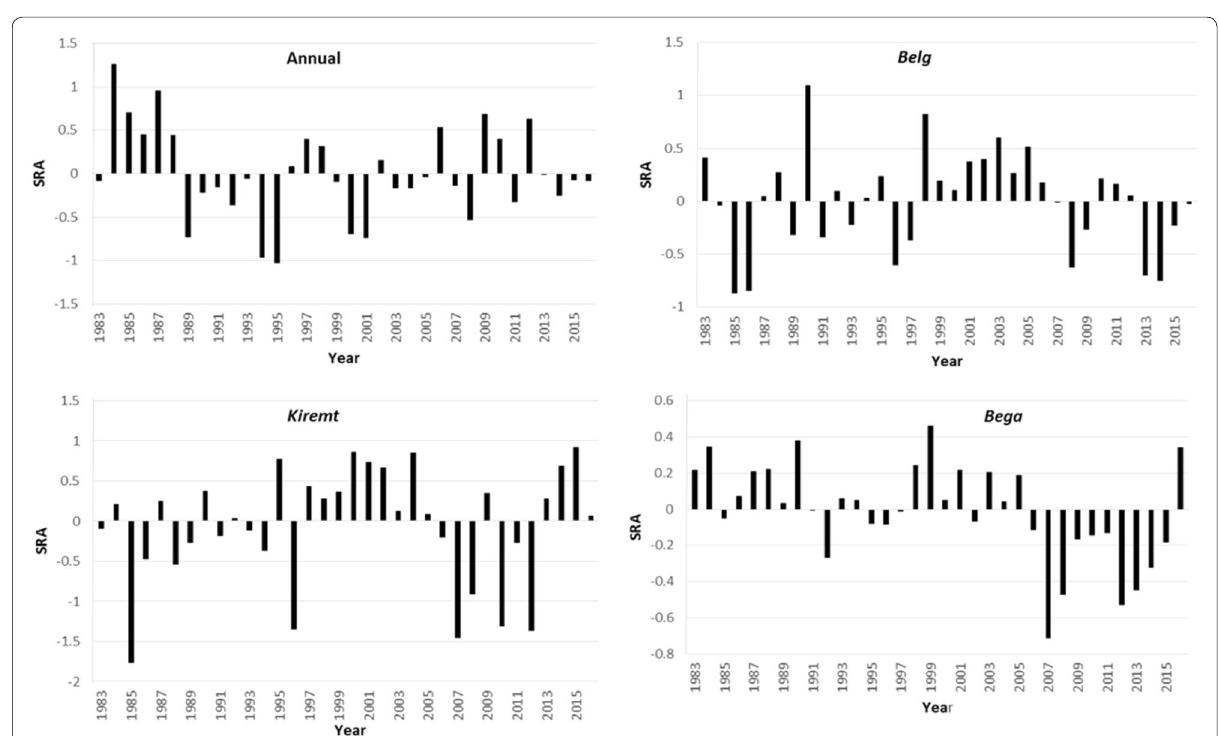
Fig. 6 Anomalies in the mean minimum temperature in Alwero